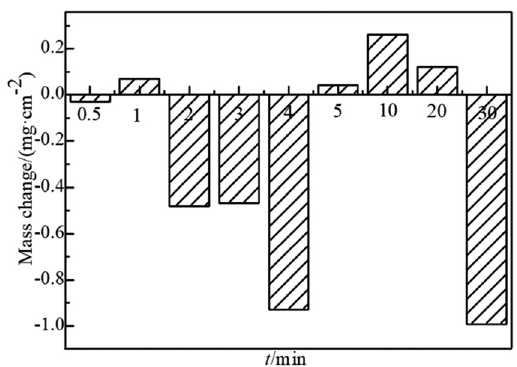
Figure 3: Sample mass change.